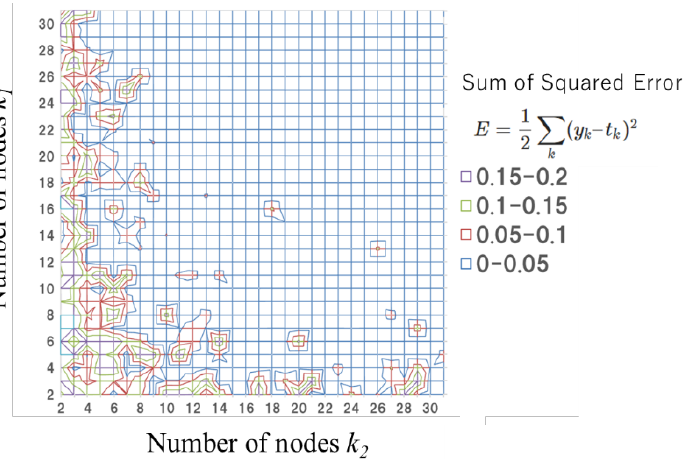
Figure 3. Example of accuracy evaluation map in sum of square error for various numbers of nodes in hidden layers based on experimental learning data based on the results shown in Figure 3.